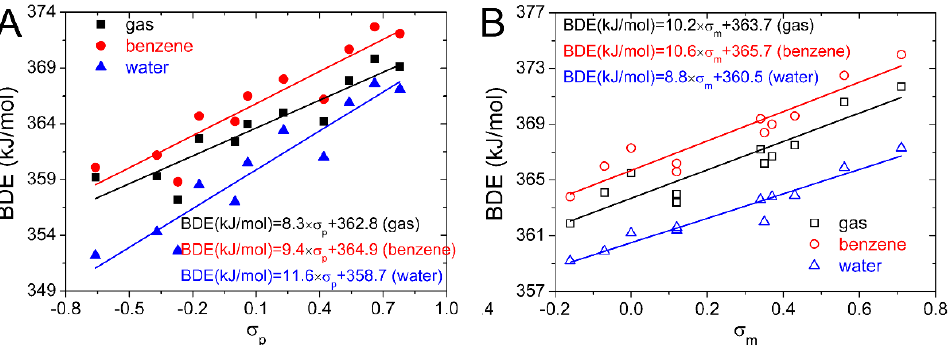
Figure 3. Dependence of BDE on Hammett sigma constants for 4′,5,7 -trihydroxyisoflavone ( A ) and 4,5,7-trihydroxyisoflavanone ( B ) in gas, benzene, and water phases.